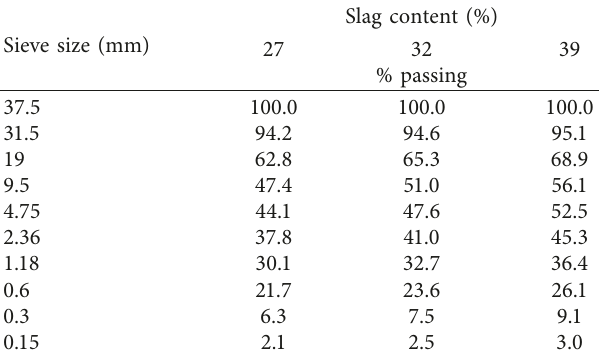
Table 4: Aggregate gradation of CTB.